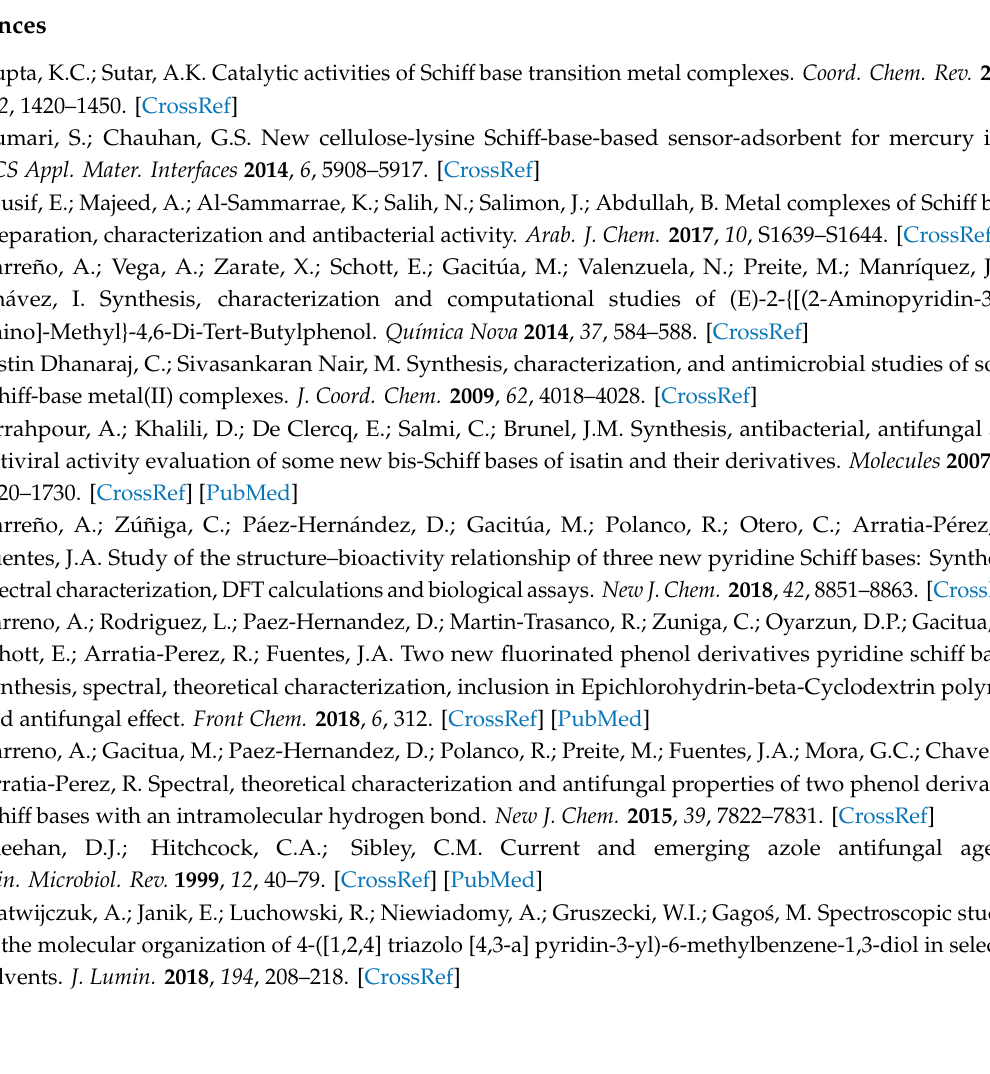
L1, Figure S24: Isosurface plots of the HOMO-2 for L1, Figure S25: MTT Assay in HeLa cells, Table S1: Positional (x, y, z) and displacement parameters for L1, Table S2: UV-Vis absorption spectra of L1 in di ff erent organic solvents, Table S3: Electrochemical signals description for pyridine Schi ff bases of this study, Table S4: Scan Rate study results for determining di ff usional control of described electrochemical processes (L1), Table S5: Scan Rate study results for determining di ff usional control of described electrochemical processes (L2), Table S6: Most important transition energies calculated for L1 in di ff erent organic solvents, Table S7: Minimal inhibition concentration ( µ g / mL) of L1 (24 h of incubation). References [95–103] are cited in the Supplementary